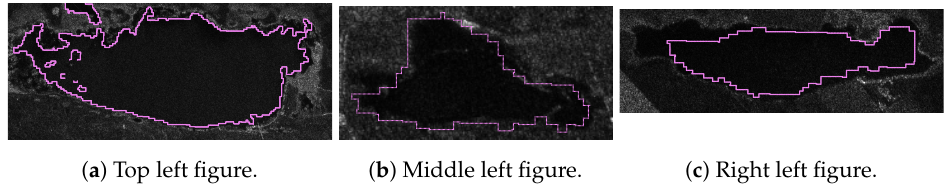
Figure 11. Estimated borders and quality measures obtained with the SNAP toolbox applied to the images of Figure